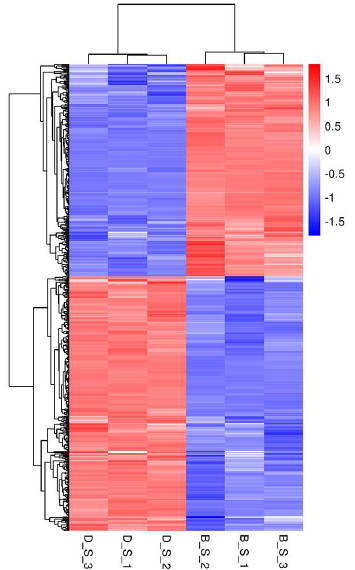
Figure 2. The volcano map depicts differentially expressed genes between the two groups of spleens. Significant differential expression genes (SDEGs) are shown as blue (down) and red (up) dots, and gray dots show a lack of significance.